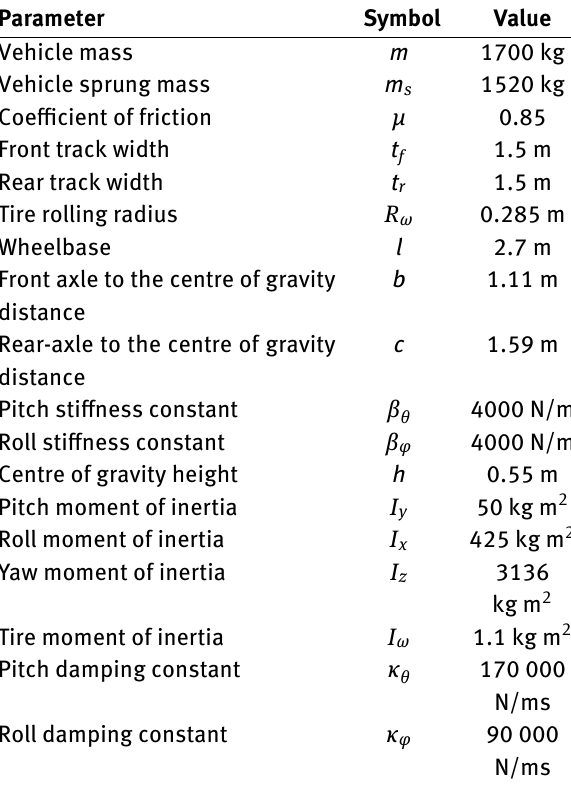
Table 1: Input parameters for the model-based vehicle dynamics framework and CarSim Education